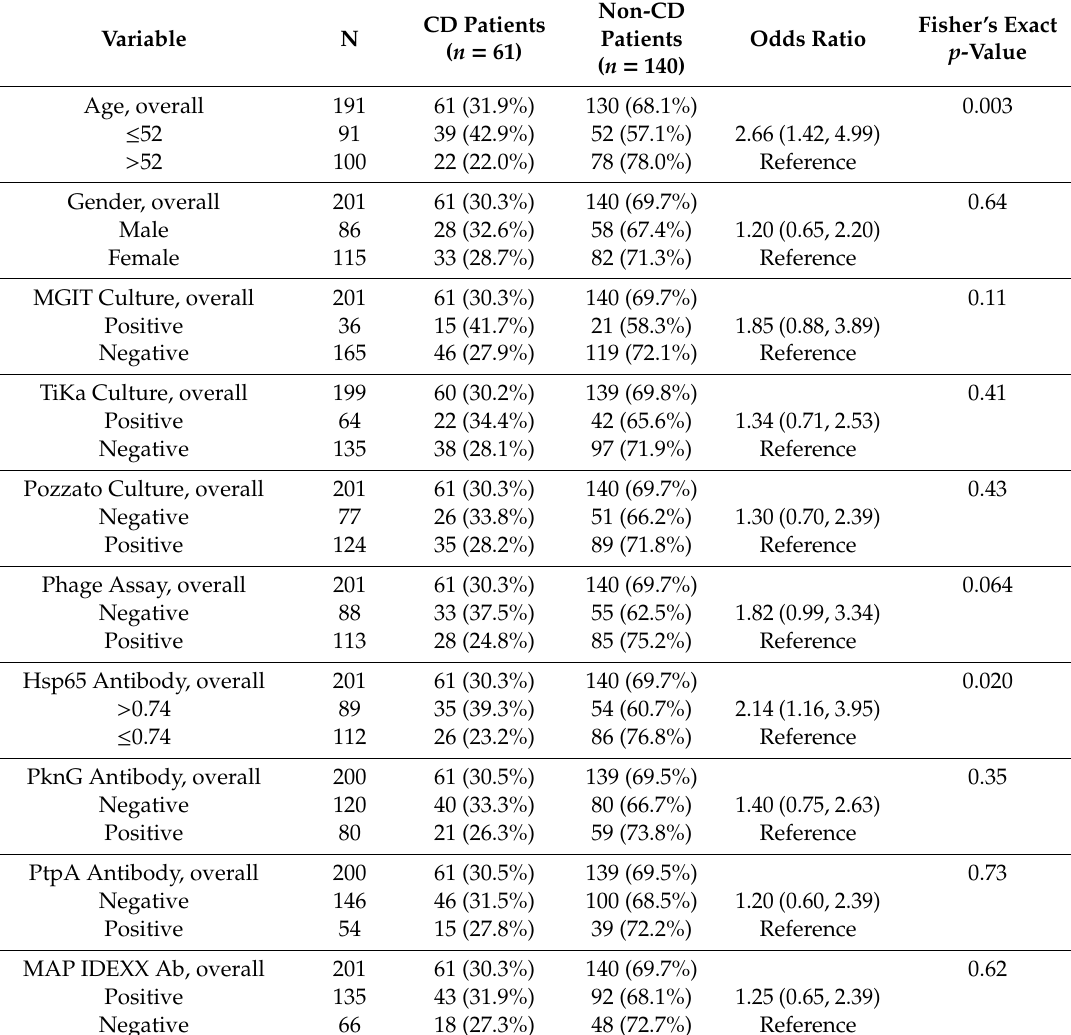
Table 3. Association analyses of clinically diagnosed CD patients with covariates of interest.